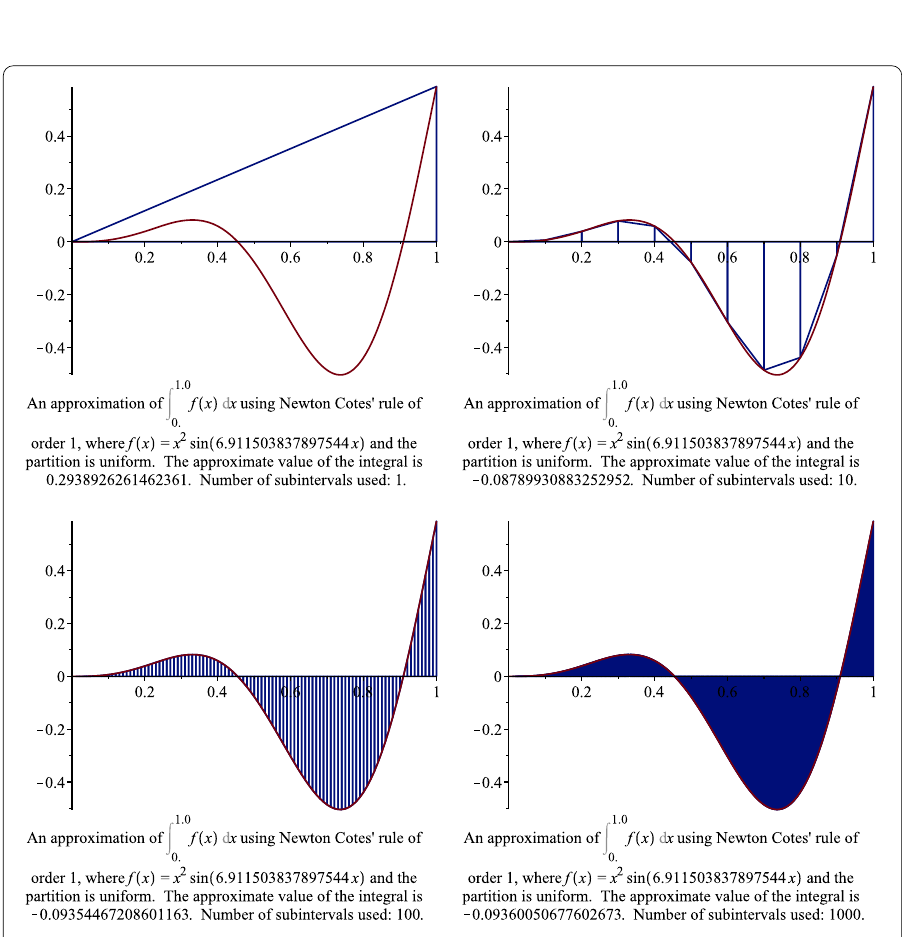
Figure 1 The process of convergence for the composite trapezoidal rule for the case ω = 1.1 and N =